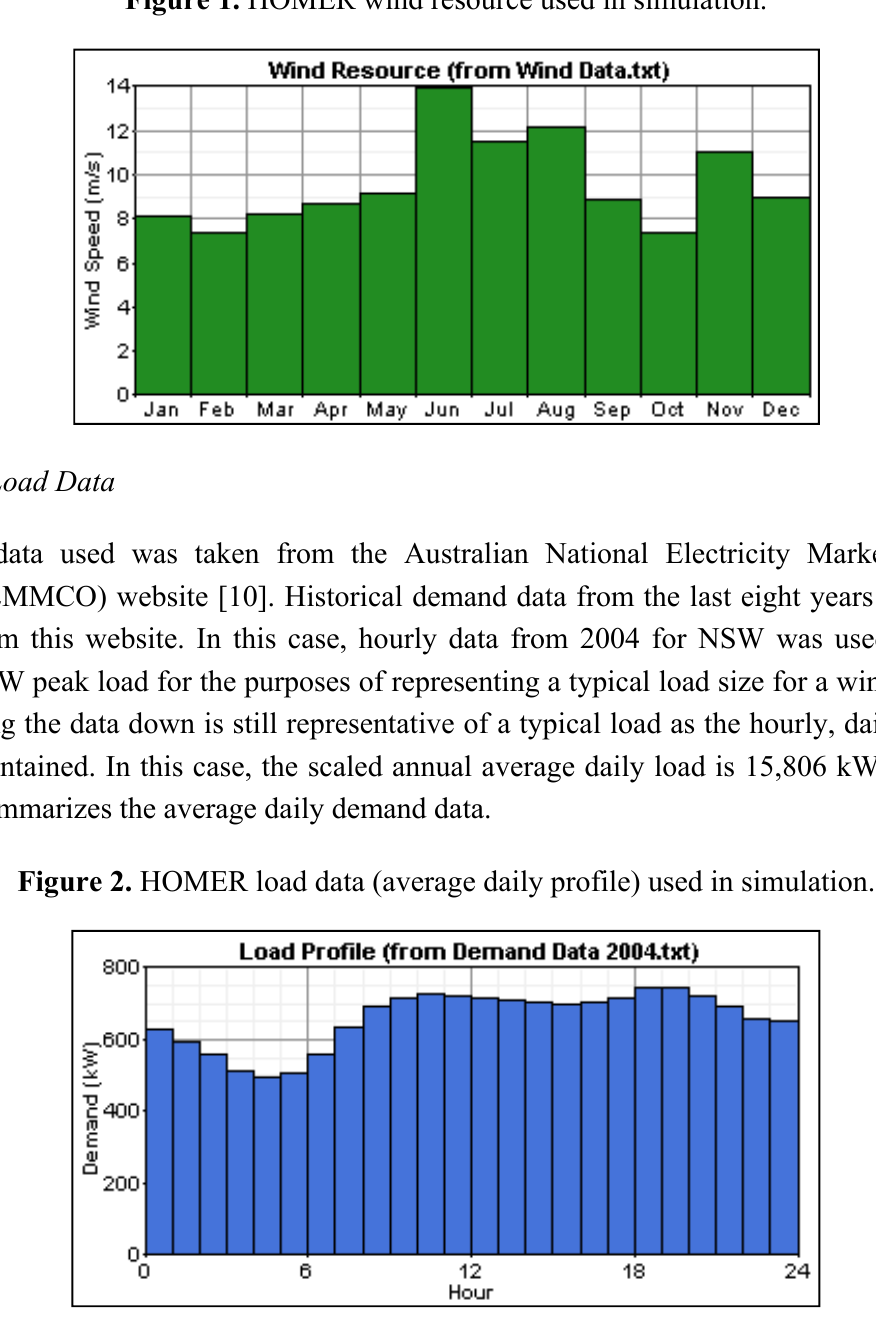
Figure 1. HOMER wind resource used in simulation.